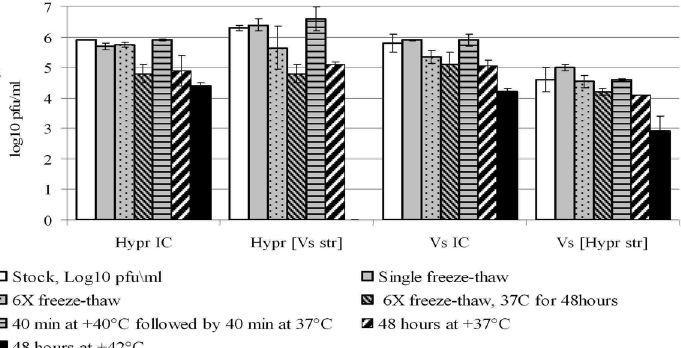
Fig 5. Virion stability. Identical aliquots of virus suspension were treated as indicated in chart legend (see also Materials and Methods) with virus titres determined by plaque infectivity assay. Error bars show 95% confidence intervals from the mean across three